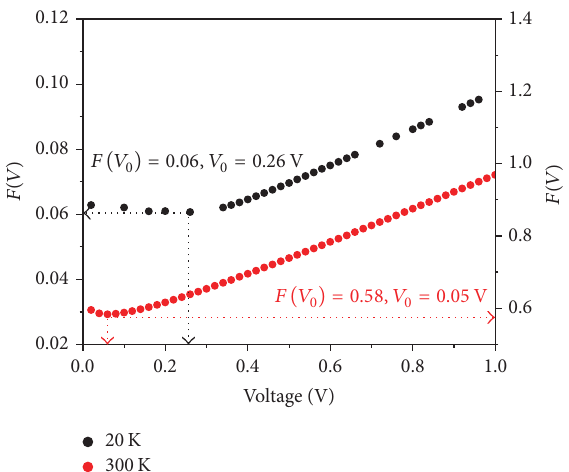
Figure 7: Plots of F ( V )- V at 20K (left axis) and at 300 K (right axis).